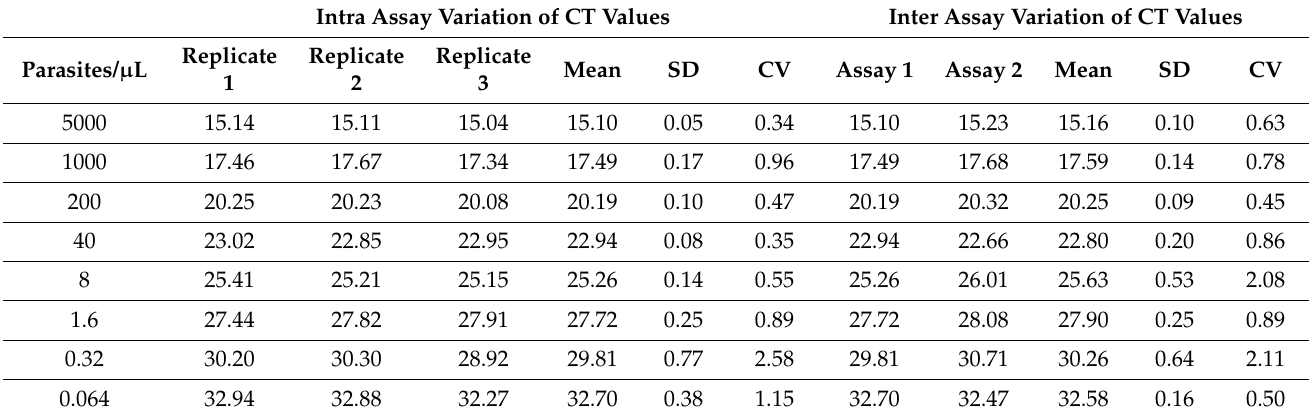
Table 1. Reproducibility and repeatability of real-time PCR assay for Pf .